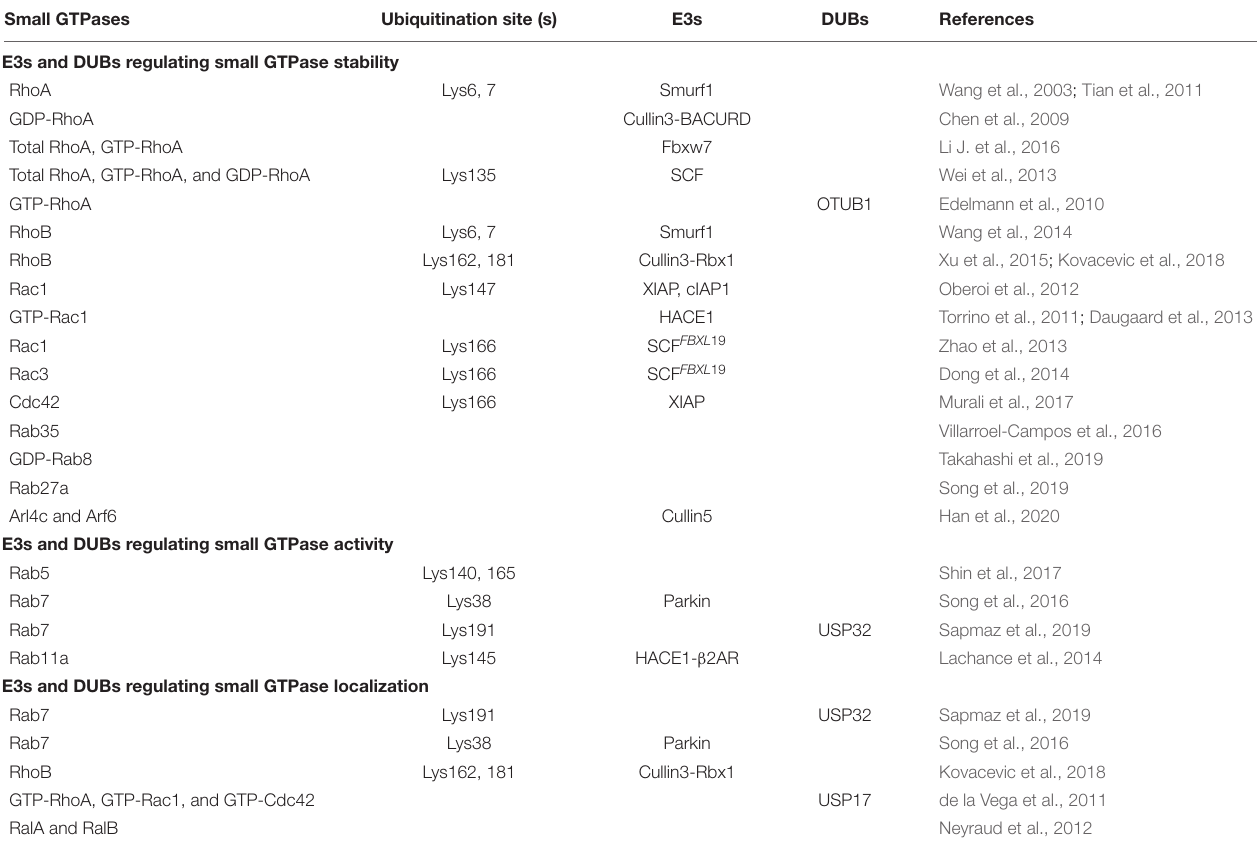
TABLE 1 | E3s and DUBs regulating small GTPase stability, activity, or